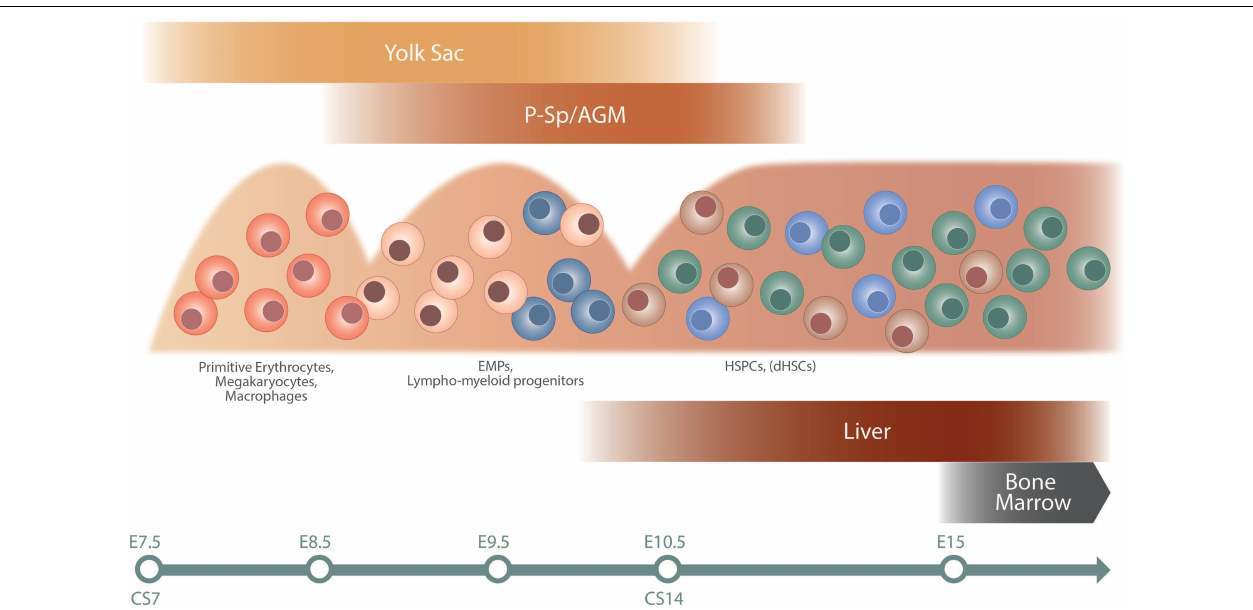
FIGURE 1 | Schematic overview of hematopoietic development. The different waves of hematopoietic cells are illustrated, as well as site of emergence (top) and colonization (bottom). The timeline at the bottom indicates approximate time in mouse (E) and human (CS). The first primitive wave of hematopoietic cells emerges in the yolk sac at approximately E7 in mouse and CS7 in human. This is followed by a second wave of EMPs and lymphoid/lympho-myeloid progenitors in mouse, a wave not fully characterized in human (Ivanovs et al., 2017). The third wave initiates in the AGM region and gives rise to HSPC and dHSCs. Progenitors from the second and third waves colonize the fetal liver. The bone marrow is colonized later in development, around E15 in mouse, and becomes the dominating hematopoietic niche around birth. AGM, aorta–gonad–mesonephros; CS, Carnegie stage; E, embryonic day; EMPs, erythro-myeloid progenitors; dHSCs, definitive hematopoietic stem cells; HSPCs, hematopoietic stem and progenitor cells; P-Sp, paraaortic